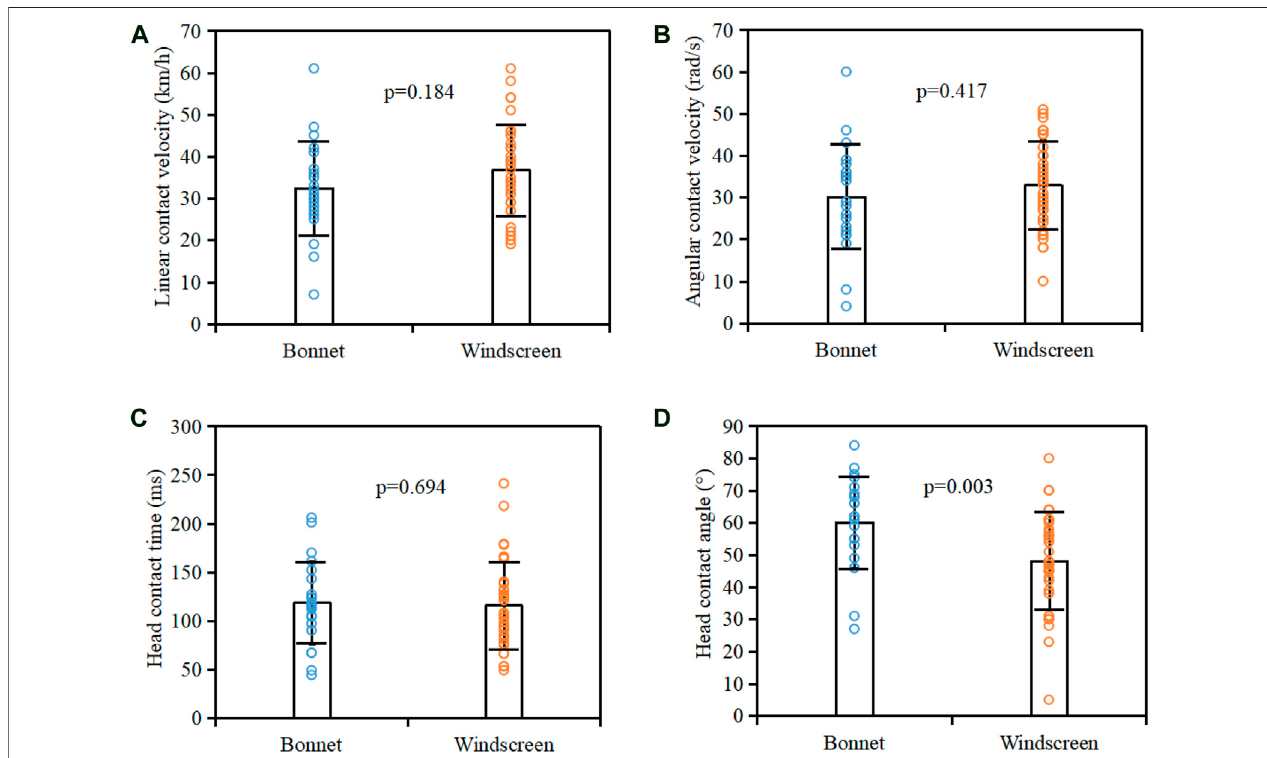
FIGURE 9 | Comparison of head linear contact velocity (A) , angular contact velocity (B) , contact time (C) , and contact angle (D) between bonnet and windscreen impacts.